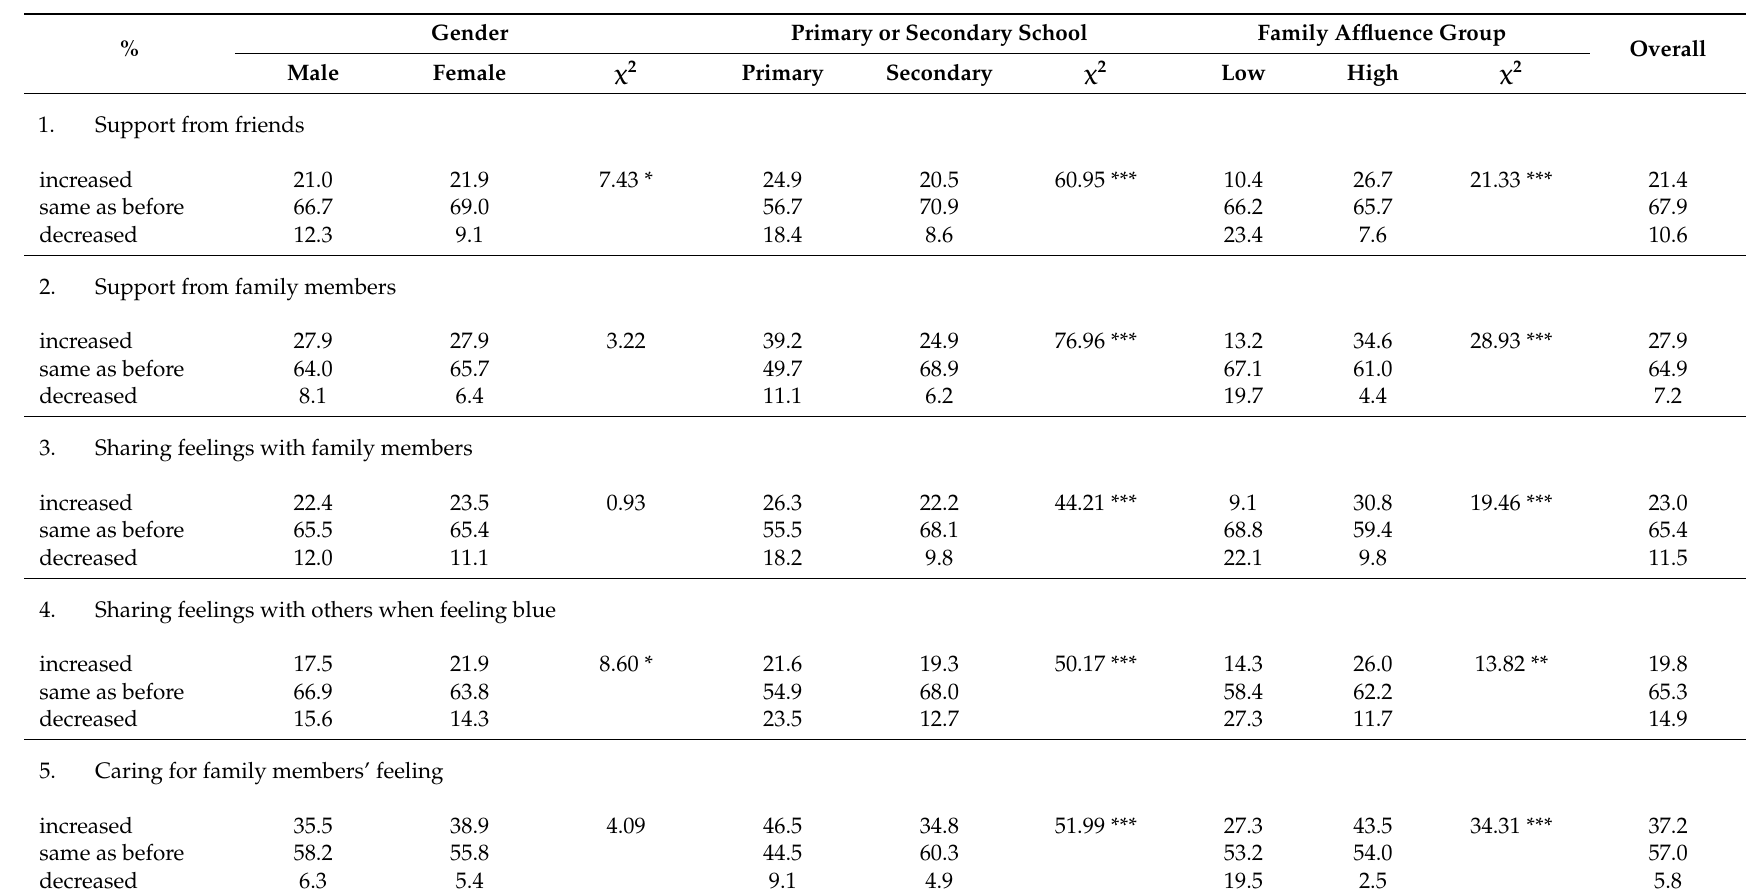
Table 3. The positive impact on social support by groups with Chi-Square ( χ 2 ) Test ( N =